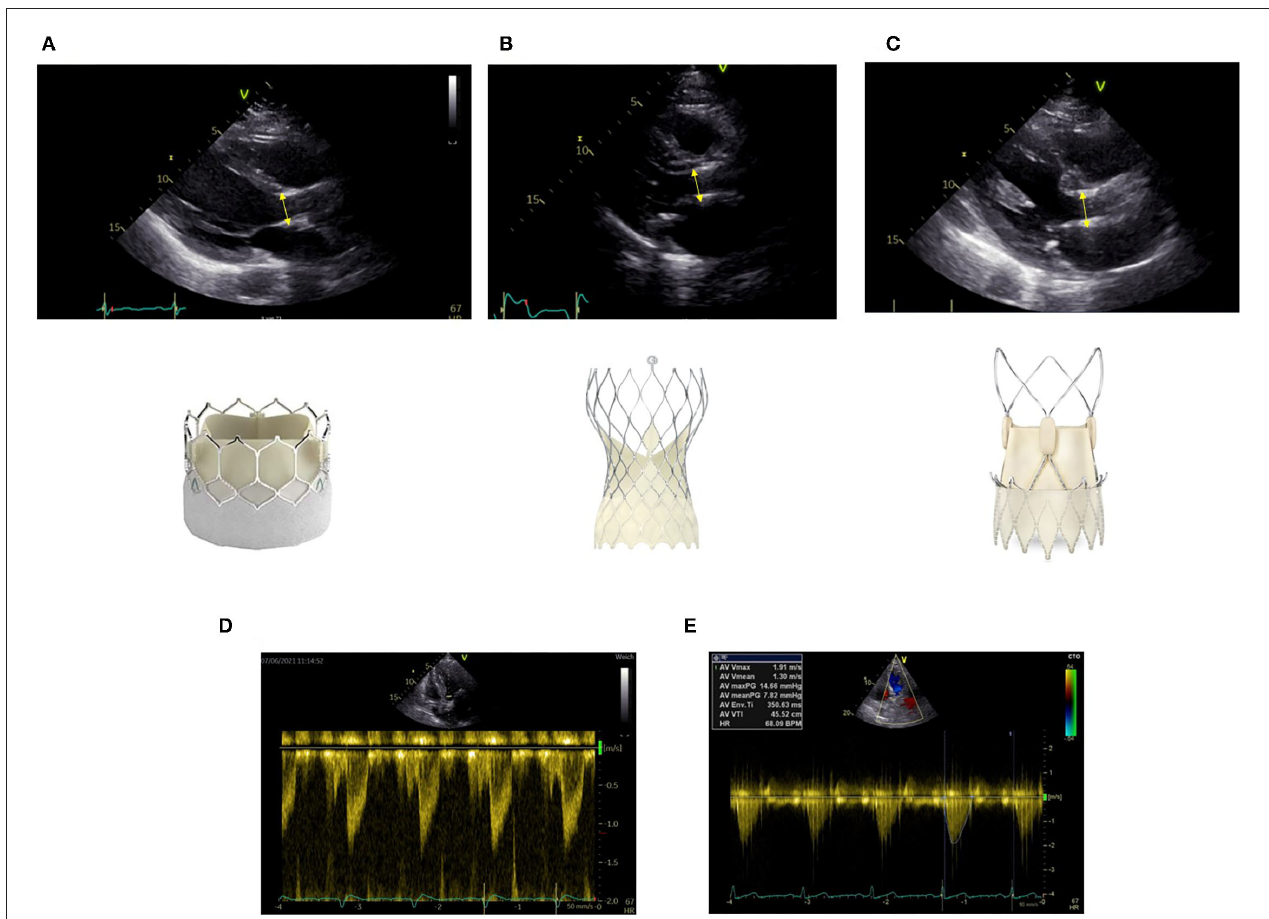
FIGURE 1 | Correct measurement of left ventricular outflow tract (LVOT) diameter at the inferior edge of the stent as indicated by the yellow bar in different transcatheter aortic valve implantation (TAVI) prostheses (A) Sapien Ultra, (B) Evolut Pro, (C) Acurate neo2. Positioning of the pulse wave Doppler sample at the same level (D) . Obtainment of highest peak velocity by continuous wave Doppler (E)